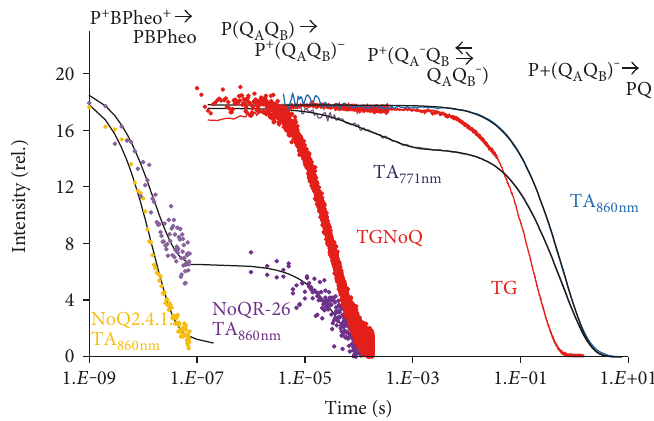
Figure 6: Representative examples of transient absorption and grating signal changes on a suspension of quinone-depleted (NoQ) RC and of a quinone-reconstituted RC; the RCs were puri fi ed from carotenoidless purple bacterium Rb. sphaeroides R-26. For comparison, the TA signal of quinone-depleted carotenoid-containing Rb. sphaeroides 2.4.1. RC is also plotted. TA was measured at two wavelengths (771 and 860nm) as indicated and described in [43, 72]. TG was measured as described in [20]. Reaction schemes for the primary charge separation PQ → P + (Q Q ) − , interquinone electron transfer P + (Q A B P + (Q Q ) − → PQ Q are also indicated. TA and TG signals are normalized to the maximum A B A B